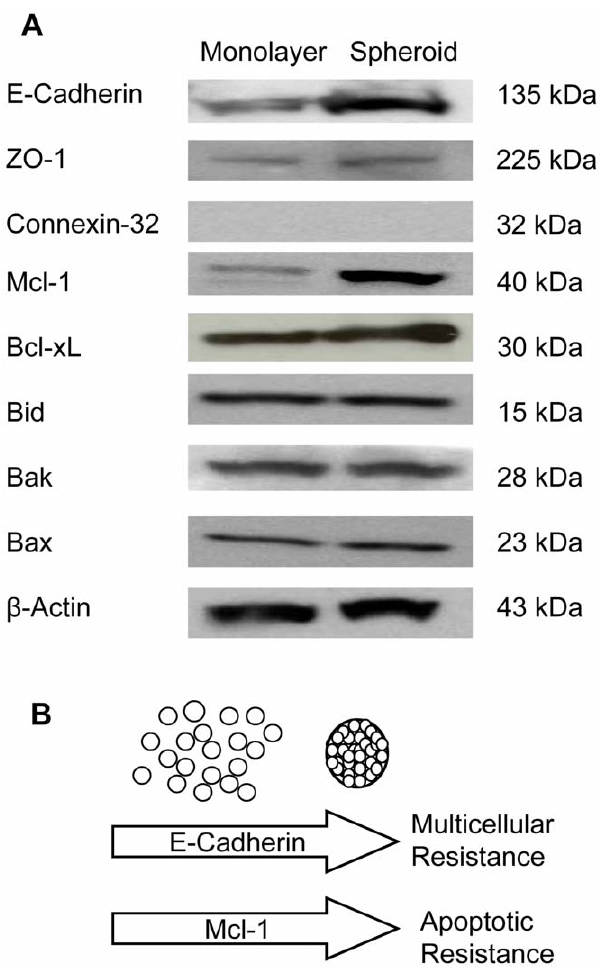
Figure 6. Expression of cell junction and Bcl-2 signaling proteins in NCI-H226 monolayers and spheroids. A . Protein expression of E-Cadherin, ZO-1, Connexin-32, Mcl-1, Bcl-xL, Bid, Bak, Bax, and b -actin examined by Western blot. B . Molecular mechanisms underlying drug resistance in tumor spheroids.